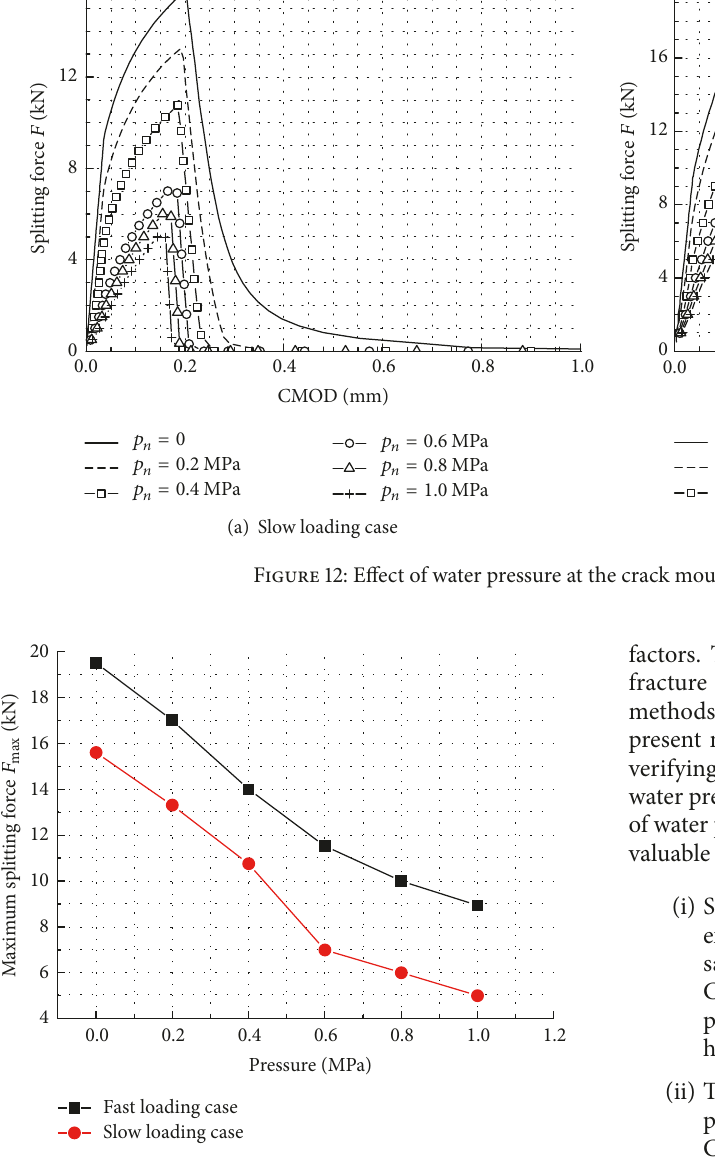
Figure 13: Maximum splitting force versus applied water pressure at the crack mouth